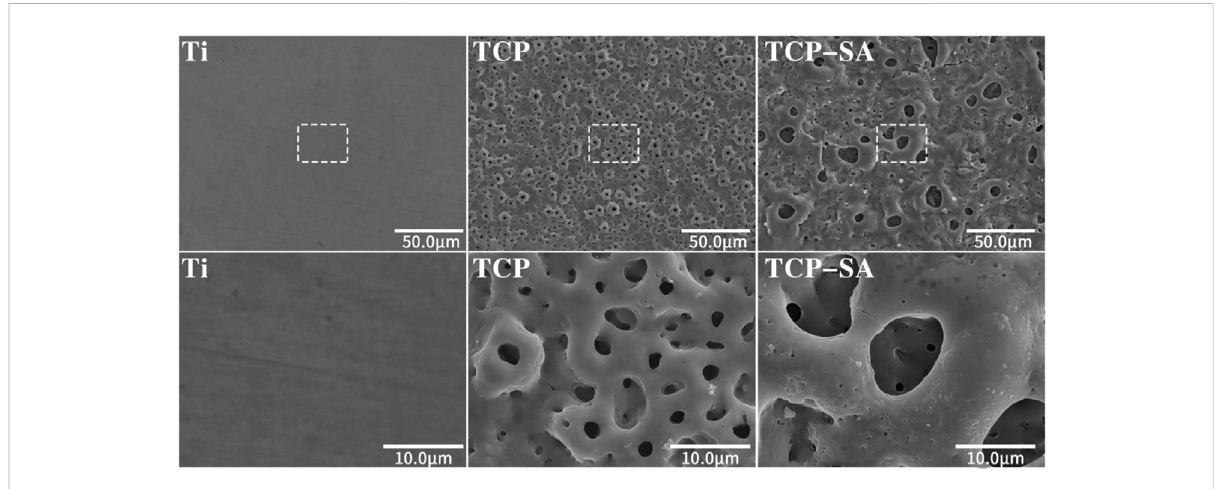
FIGURE 1 SEMsurfacemorphologyofdifferentsamplesunderlowandhighmagni fi cation(×600and×3500).Theplasmaoxidationtime is5 min,andthe reaction temperature is room